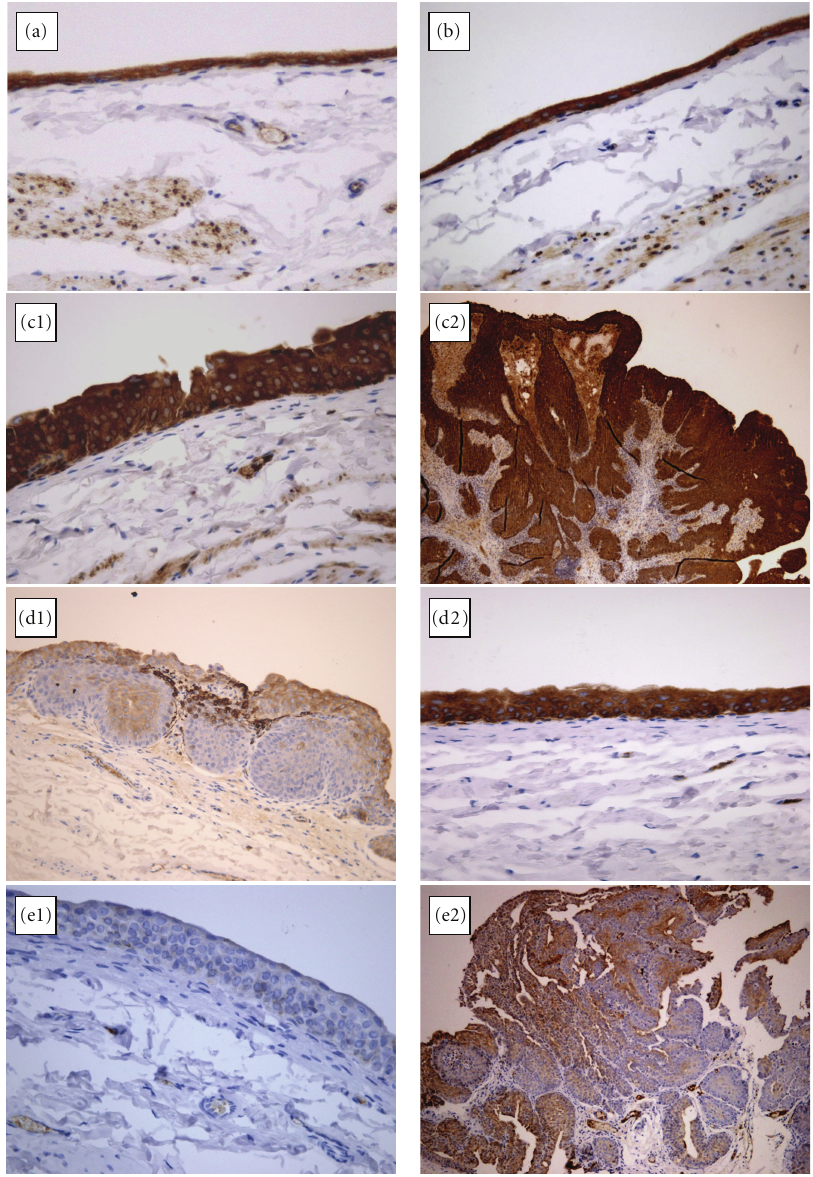
Figure 5: COX-2 immunohistochemistry (the positivity is the brown nuclear staining) in the five groups under study: control (a), CEL (b), carcinogen (BBN) group (c1 and c2), preventive CEL+BBN-P treatment (d1 and d2), and curative CEL (BBN+CEL-C group) use (e1 and e2) (original magnification X